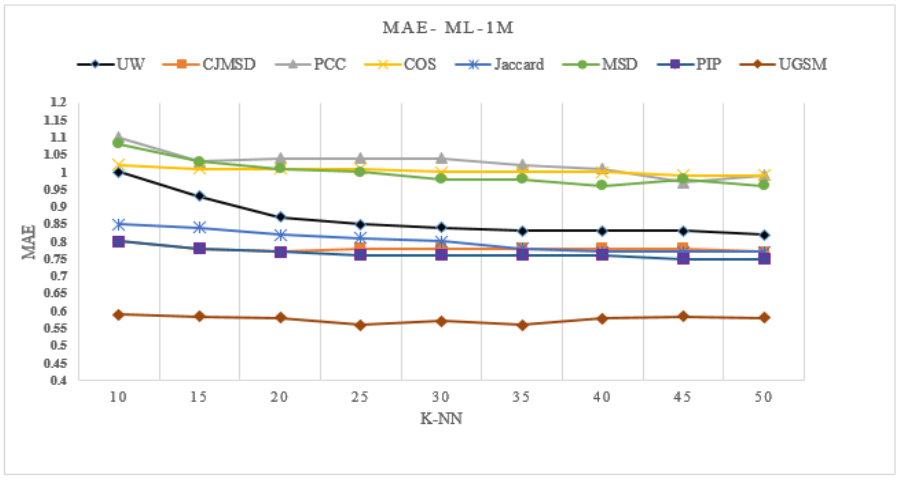
Figure 7. Comparison of the UGSM’s accuracy to the state-of-the-art algorithms for the ML1 dataset. The X -axis is the K-NN and the Y -axis is the MAE value.